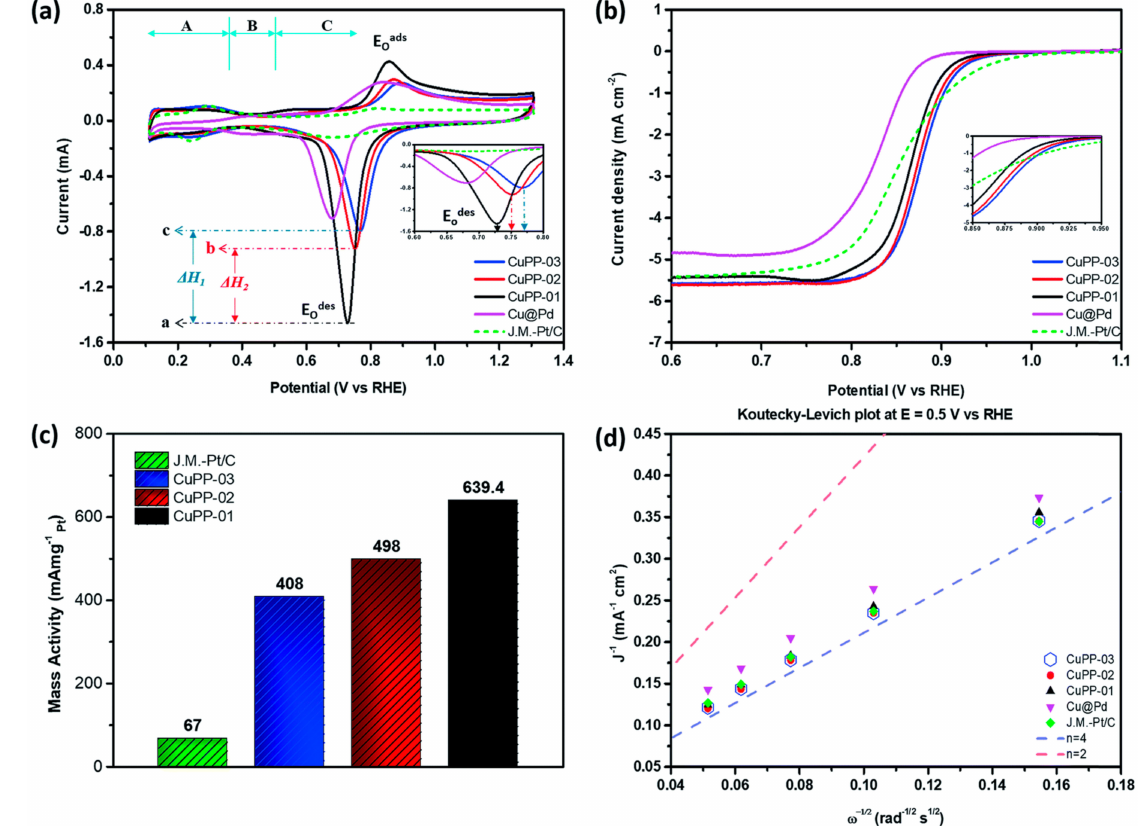
Figure 6. ( a ) The cyclic voltammetry, ( b ) linear sweep voltammetry curves, ( c ) ORR mass activities, and ( d ) Koutecky–Levich plot of Cu@Pd core-shell (CuPP) NCs with di ff erent Pt-loadings. (Reproduced with permission from [48], Royal Society of Chemistry,